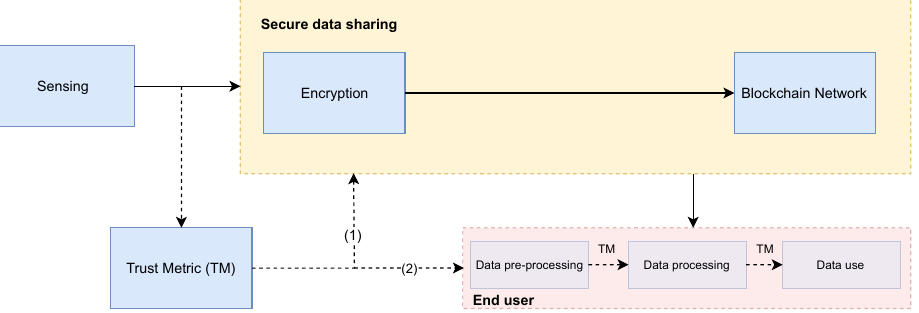
Figure 7. Flow diagram of secure data sharing with integration of trust